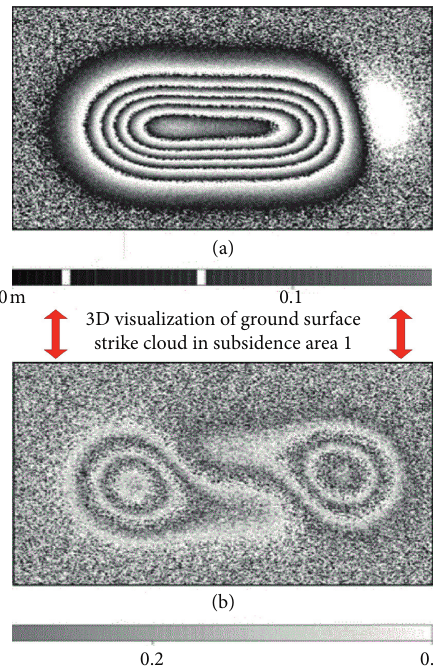
Figure 13: 3D visualization of ground surface strike cloud in subsidence